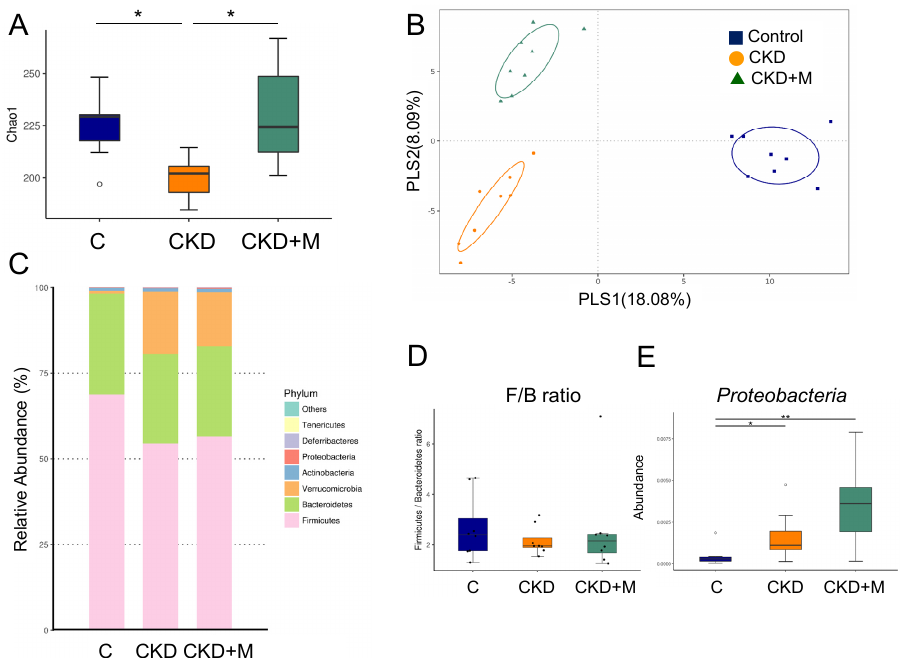
Figure 1. Gut microbiota composition in male rats. ( A ) α -diversity represented by Chao1 analysis, ( B ) β -diversity measured by partial least squares discriminant analysis (PLS-DA), ( C ) relative abun- dance of the top phyla of the gut microbiota among the three groups, ( D ) the Firmicutes to Bacteroidetes ratio, and ( E ) the abundance of phylum Proteobacteria among the three groups. N = 8/group. Data are shown as means ± SD. The single asterisk indicates p < 0.05 vs. C. The double asterisk indicates p < 0.01 vs. C.